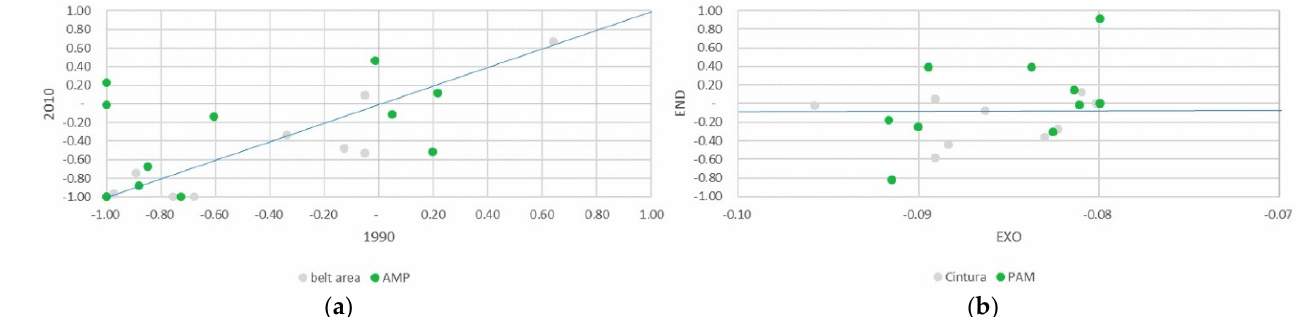
Figure 25. ( a , b ) AMP- PSI and DPSI for sheep. Source: Drawn up by the authors using data provided